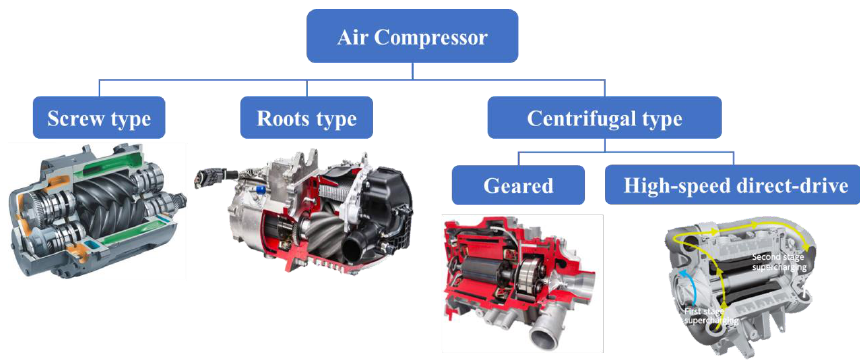
Figure 10. Classification of compressors for fuel cell vehicles.